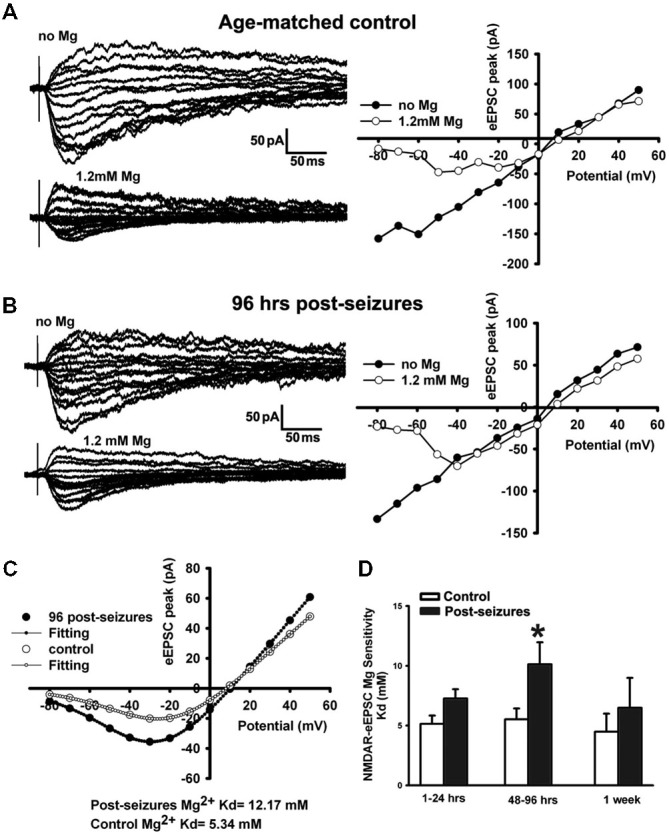
Reduction of Mg2+-sensitivity of GluN eEPSCs at 48–96 h in hippocampal CA1 neurons following HS. (A,B) Representative traces of evoked GluN EPSCs (left panels) at a holding potential from −80 mV to +50 mV in ACSF with/without Mg2+ (1.2 mM) in CA1 pyramidal neurons in slices from control and 96 h post-HS rats. Right panels, corresponding I-V plots of the peak amplitudes of GluN eEPSCs. (C) GluN eEPSC I-V curves (with 1.2 mM Mg2+ in ACSF) and corresponding fitted Woodhull curves in CA1 pyramidal neurons in slices from control (empty circles) and 96 h post-HS rats (filled circles). (D) Group data of fitted Woodhull Kd values in CA1 pyramidal neurons in slices from 1–24 h (n = 10 cells), 48–96 h (n = 12 cells), 1 week post-HS (n = 5 cells) and littermate control rats (n = 5–11 cells). *p < 0.05. Error bars indicate S.E.M.